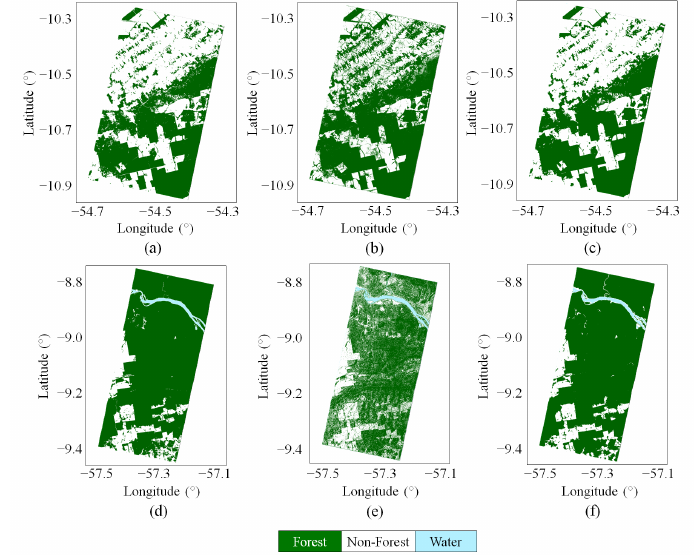
Figure 6. Forest classification maps for two TanDEM-X images acquired over the Amazon rainforest. The top row depicts an image acquired in April 2012 with h Amb = 32 m, while the bottom row shows an image acquired in May 2013 with h Amb = 99 m. Each row refers to an acquisition, and the Landsat forest map used as a reference is depicted ( a , d ), together with TanDEM-X forest maps obtained with the baseline clustering approach ( b , e ) and the proposed CNN model ( c , f ). Water bodies are directly detected in the TanDEM-X CNN images ( c , f ), while the TanDEM-X WBL [28] was applied as masking layer to the forest maps generated with the clustering approach ( b , e